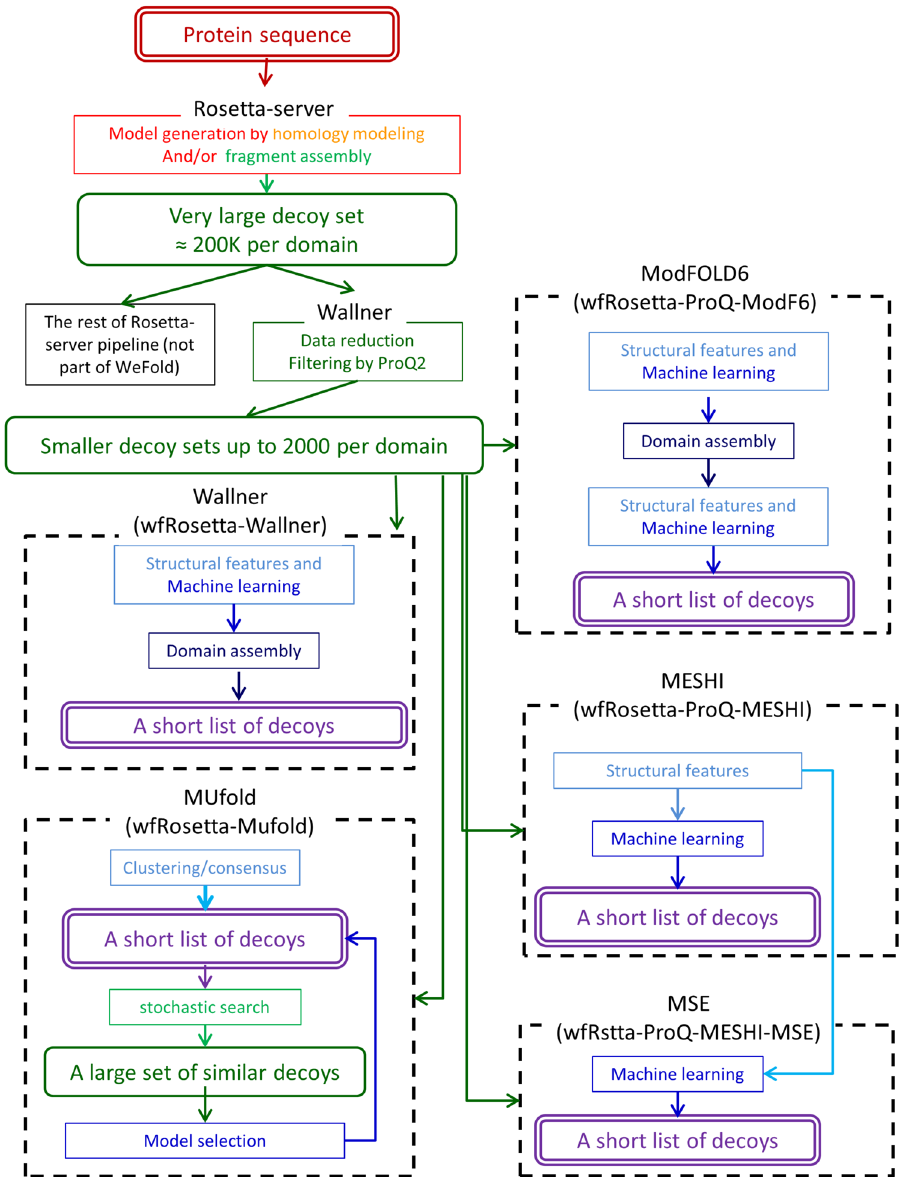
Figure 2. An illustration of the WeFold pipeline concept. The figure presents a schematic depiction of 5 WeFold3 pipelines, which share their first components and differ in the final stages. Graph representation and colors are based on Fig. 1. A complete list of all the WeFold2 and WeFold3 pipelines is presented in Table 1 and in the main